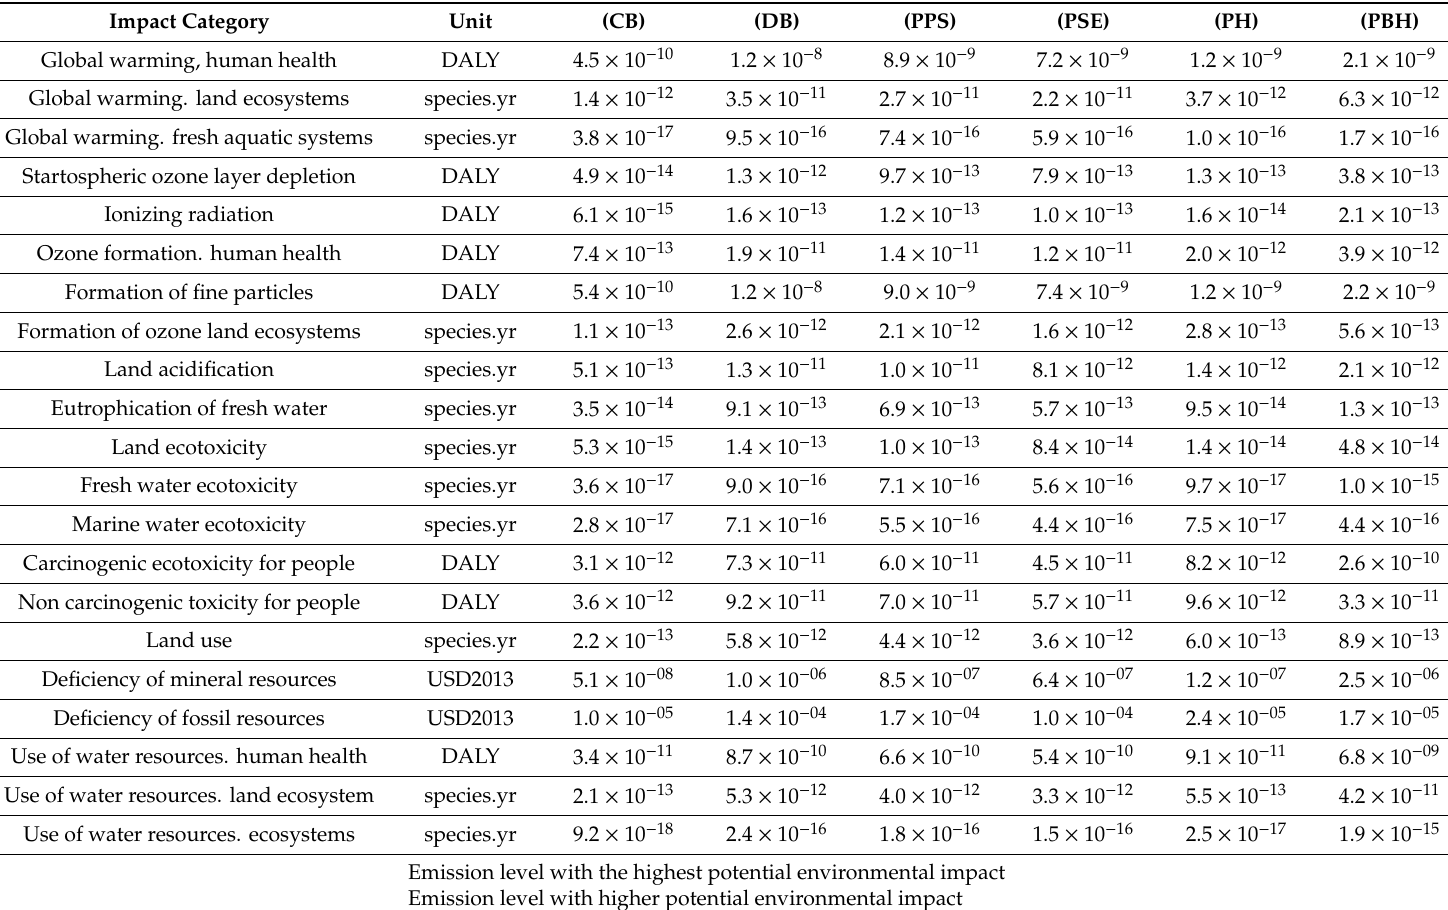
Table 2. Results of characterizing environmental impacts of a bottle shaping